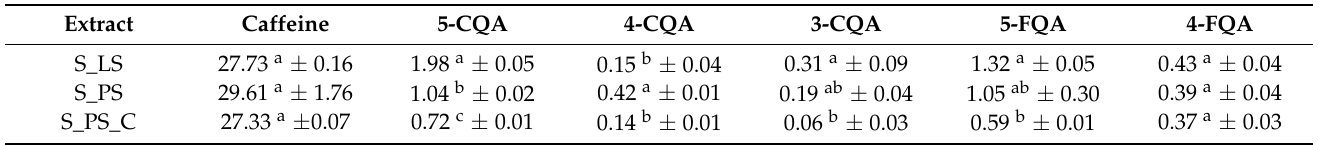
Table 1. Caffeine and chlorogenic acids contents (in mg/g of freeze-dried powder) of the different coffee silverskin